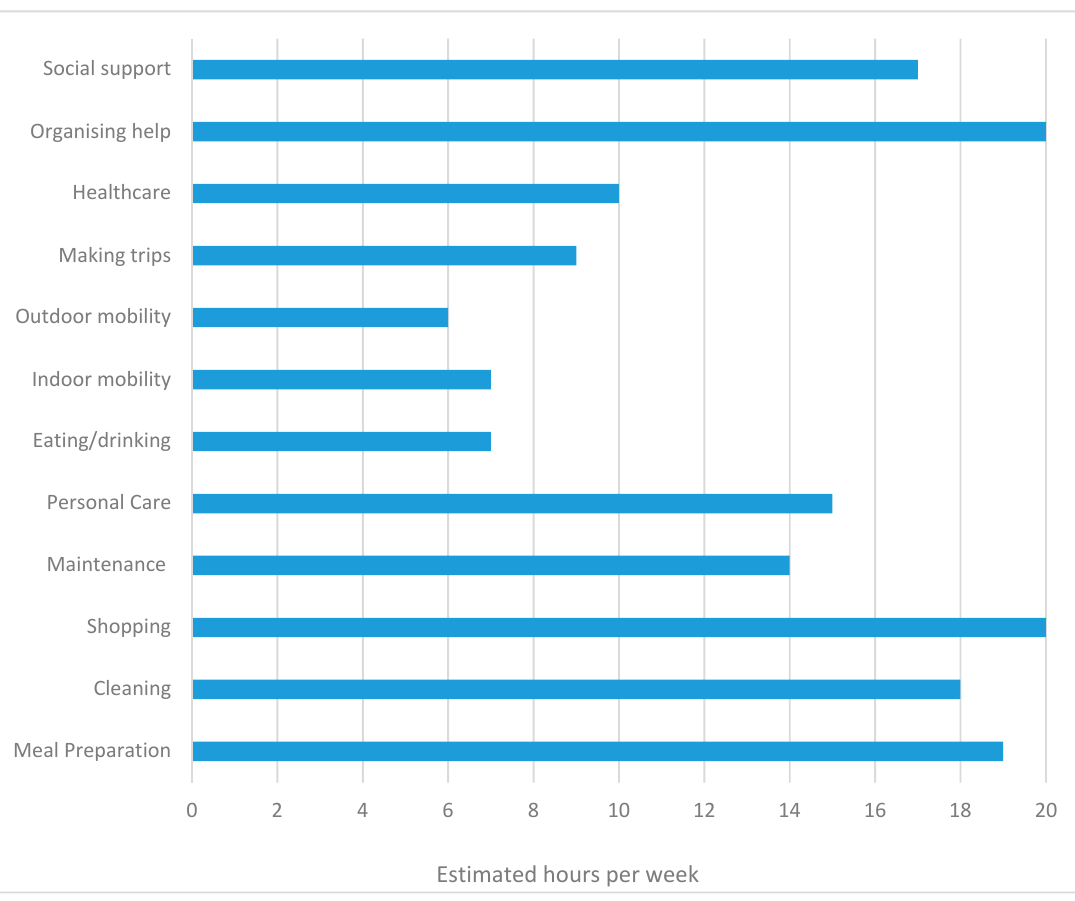
Figure 1. Self-reported estimated hours of care per week attributed to caregiving tasks.